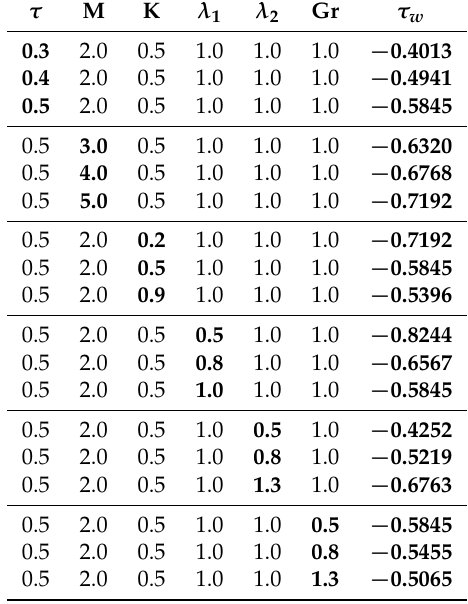
Table 2. Varaition of skin friction for different values of